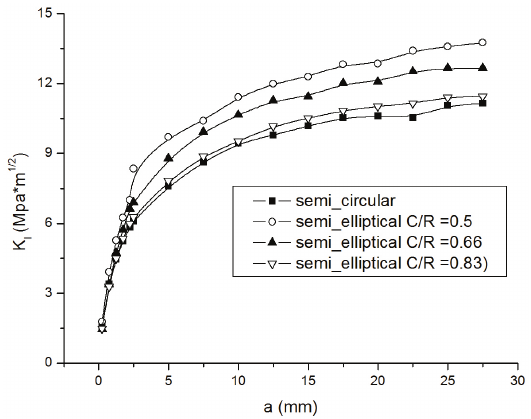
Figure 3. Variation of the SIF according to the crack length for different ratio c/R.